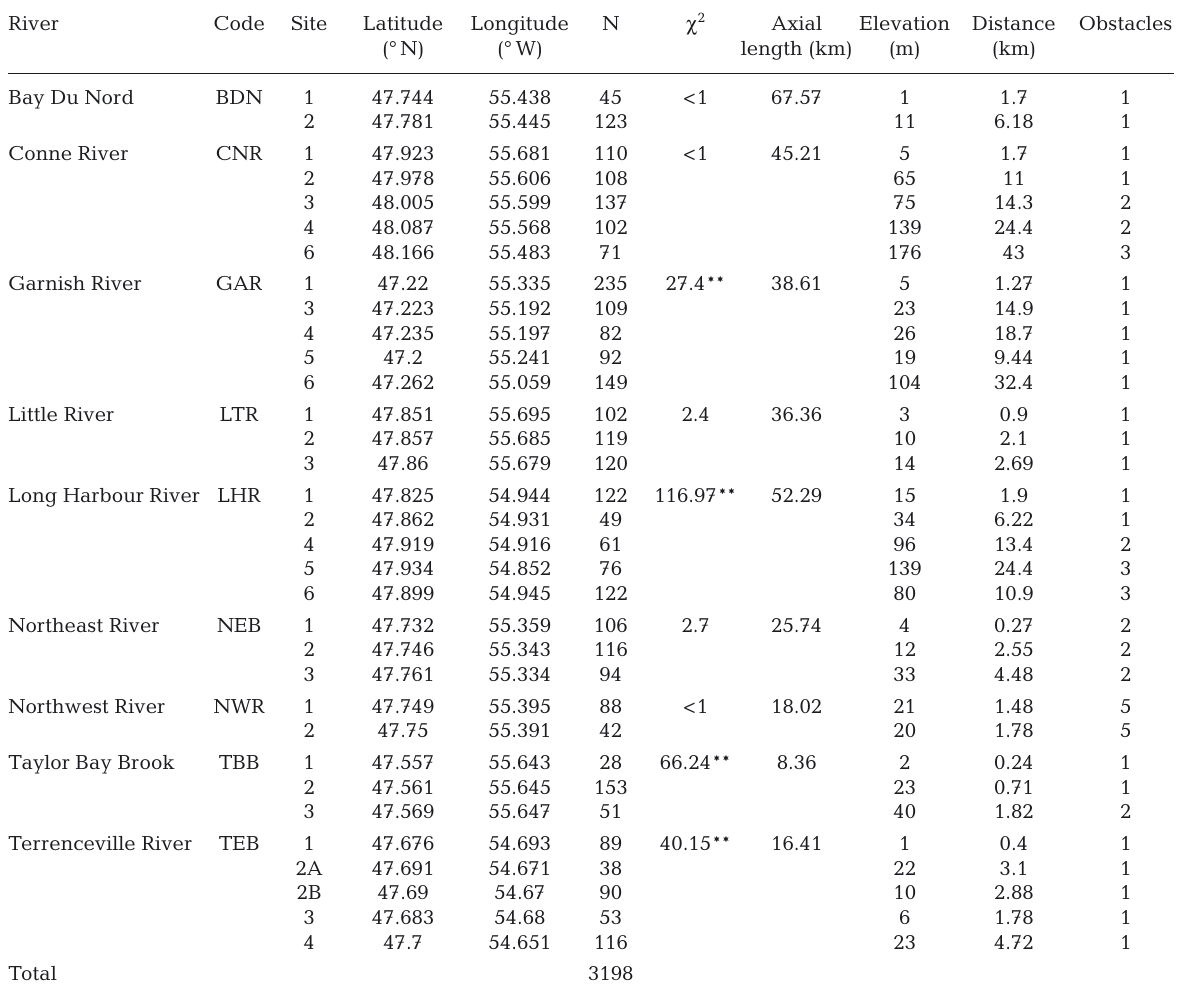
Table 1. Site locations (in decimal degrees), sample sizes (N) and χ 2 statistics of intra-river group composition of